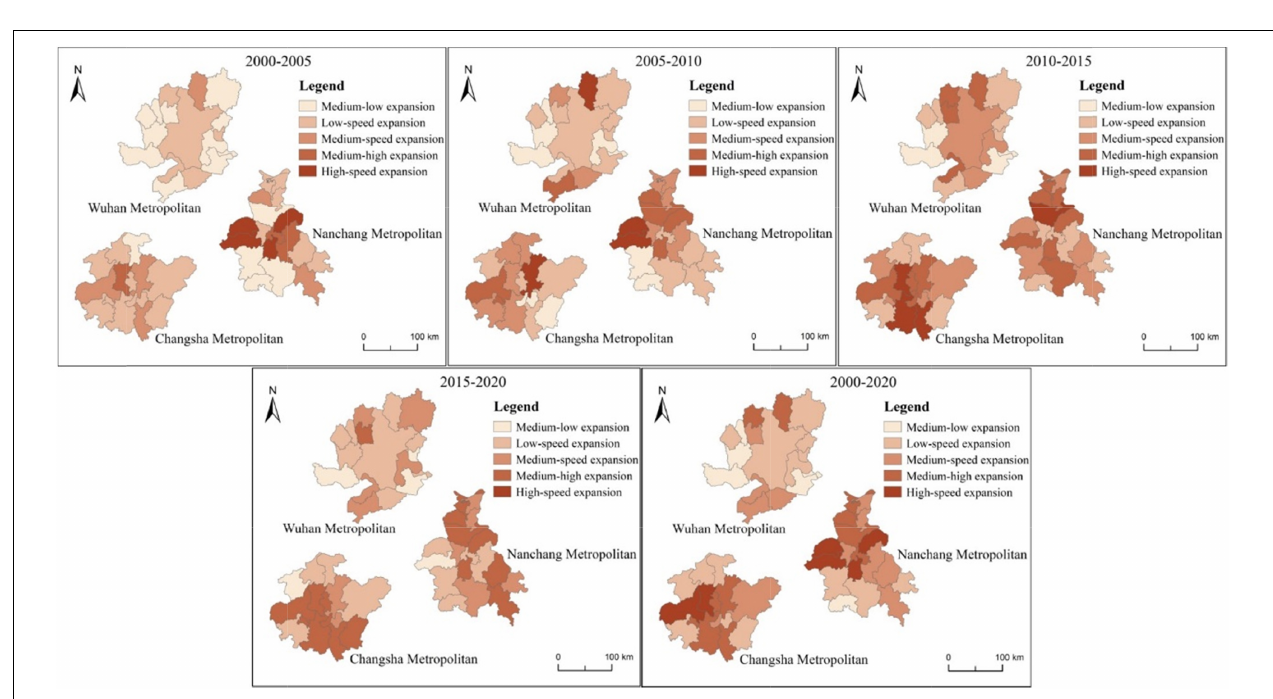
FIGURE 2 | Spatial pattern of difference of construction land expansion intensity from 2000 to 2020.